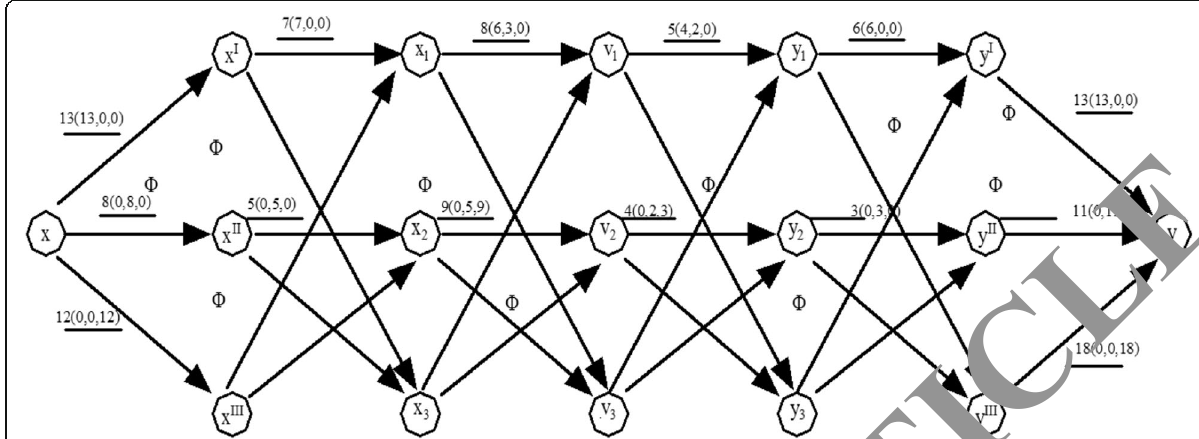
Fig. 2 The measures to improve the judicial execution plan in the administrative law system based on the annealing